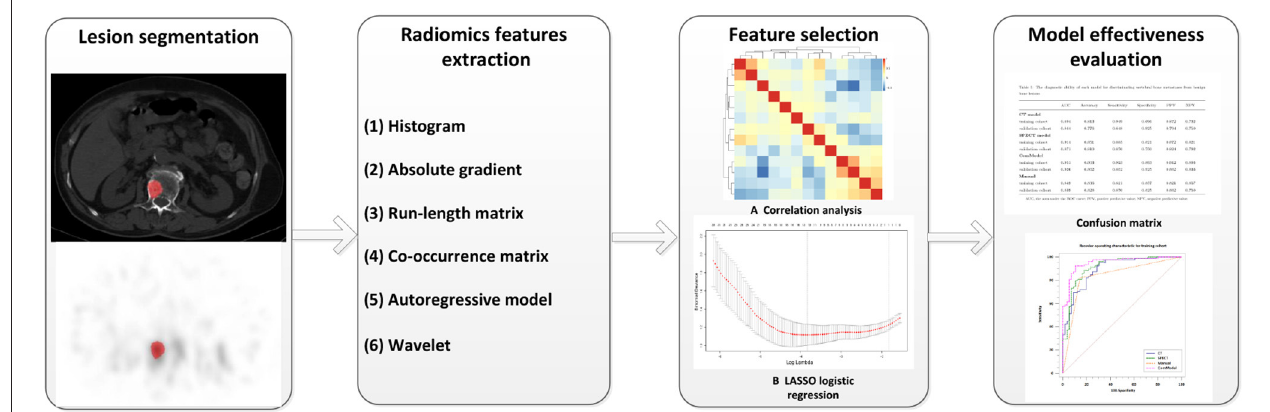
FIGURE 2 | The flowchart of our